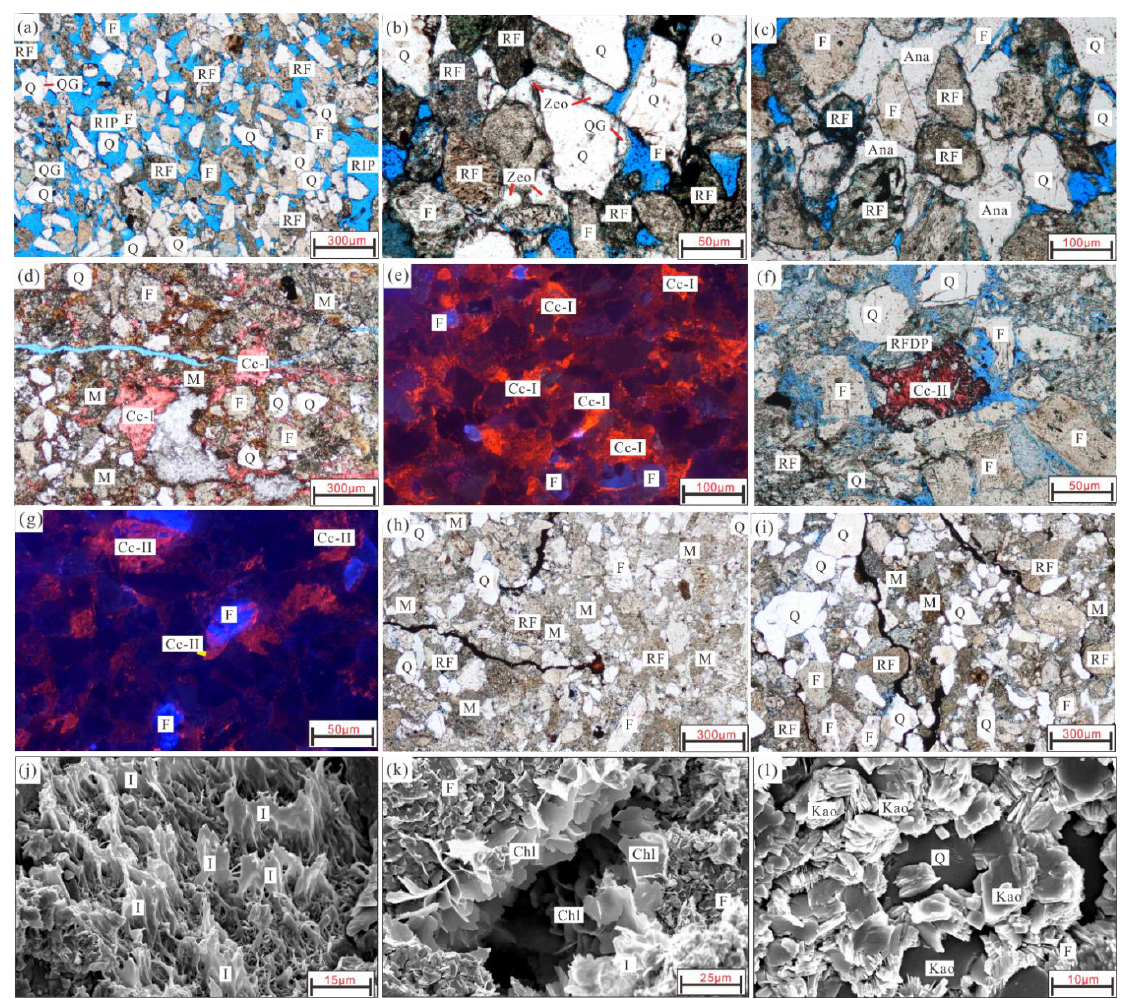
Figure 4. Casting thin sections of the tight sandstone samples in Toutunhe Formation, showing mainly diagenetic charac- teristics of 3 types of lithofacies. ( a ) weakly diagenetic reformed facies, residual intergranular pores widely developed with weakly dissolved, 3643.2 m, Y1 well, plane-polarized light; ( b ) weakly diagenetic reformed facies, analcime filled in residual intergranular pore, 3643.2 m, Y1 well, plane-polarized light; ( c ) poikilitic analcime filling in residual intergranular pores, 3907.4 m, Y1 well, plane-polarized light; ( d ) carbonate cemented facies, poikilitic calcite filling the residual intergranular pores, cut by fractures, 3809.5 m, Y1 well, plane-polarized light; ( e ) carbonate cemented facies, poikilitic calcite emitting bright orange fluorescence, 3809.5 m, Y1 well, cathodoluminescence image; ( f ) carbonate cemented facies, ferrocalcite occluding the dissolution pore of rock fragment, 3182.3 m, well Y2, plane-polarized light; ( g ) ferrocalcite emits dark orange fluorescence, 3809.8 m, well Y1, cathodoluminescence image; ( h ) matrix with a widely developed but small proportion of residual intergranular pores, most of micro-fractures were filled with bitumen, 3182 m, well Y2, plane-polarized light; ( i ) pore-filling matrix widely developed, most of micro-fractures were filled with bitumen, 3181 m, well Y2, plane-polarized light; ( j ) fibrous illite developed on the mineral grain, 3709 m, Y1 well, SEM; ( k ) Lining-blade shape chlorite, 3809.1 m, Y1 well, SEM; ( l ) kaolinite aggregates in book-page shape filled primary pores, 3643.2 m, well X1, SEM. Q: quartz; QG: quartz overgrowth; F: feldspar; MRF: metamorphic rock fragment; VRF: volcanic rock fragment; SRF: sedimentary rock fragment; RF: rock fragment; Cal-I: calcite; Cal-II: ferrocalcite; Sid: siderite; C: chlorite; Kao: kaolinite; I: illite; Zeo: zeolite; M: matrix; RIP: residual inter-granular pore; MP: matrix pores: FDP: feldspar dissolution pores; RFDP: rock fragment dissolution pores; IPC: intercrystalline pores of clay; CIP: clay mineral intergranular